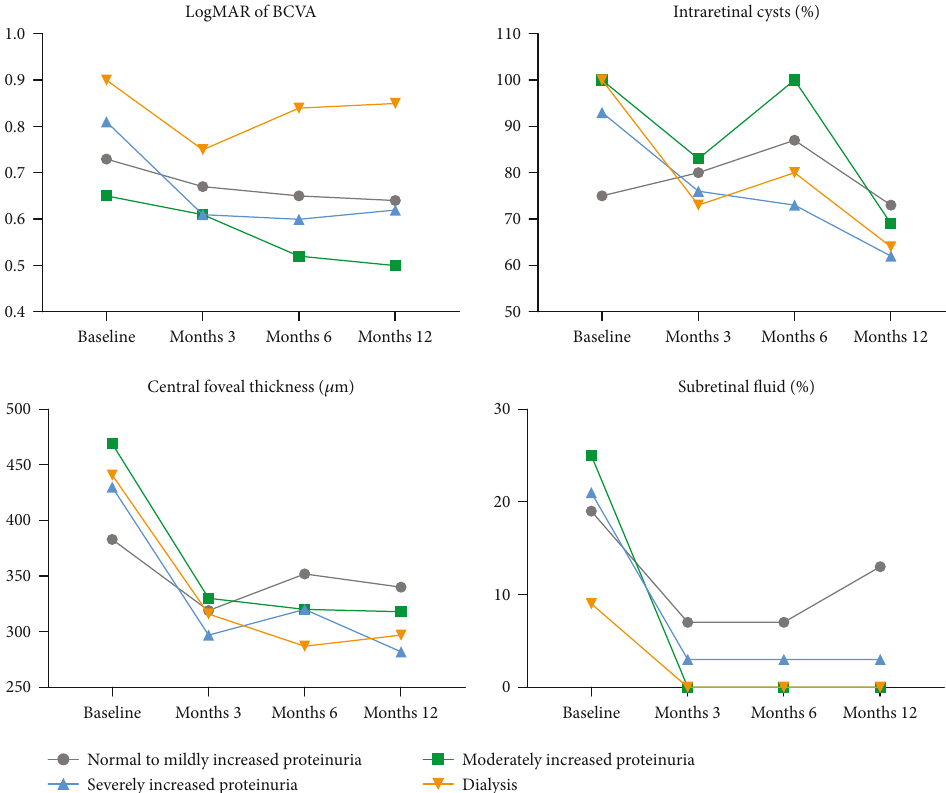
Figure 1: Changes in visual acuity (presented in logMAR of BCVA), central foveal thickness, presence of intraretinal cyst, and presence of subretinal fl uid after intravitreal ranibizumab injection for diabetic macular edema in di ff erent groups of